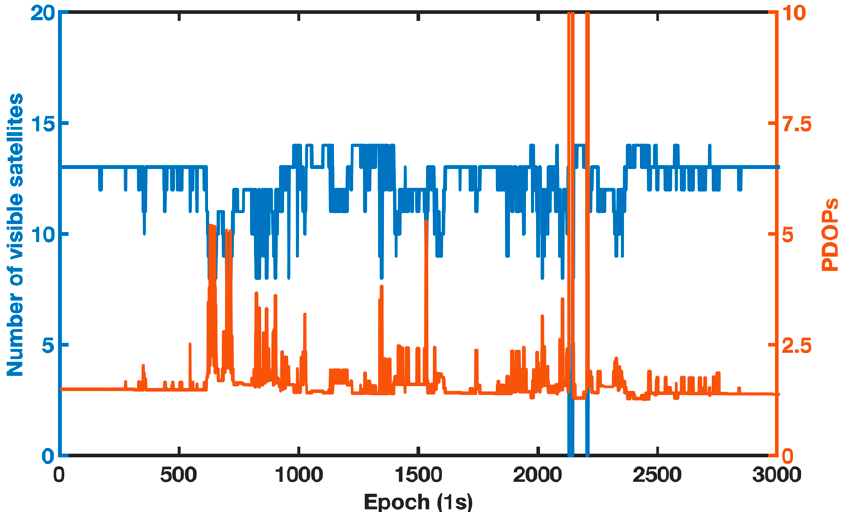
Figure 8. Number of visible BDS-3/GPS satellites and PDOPs in Experiment B.